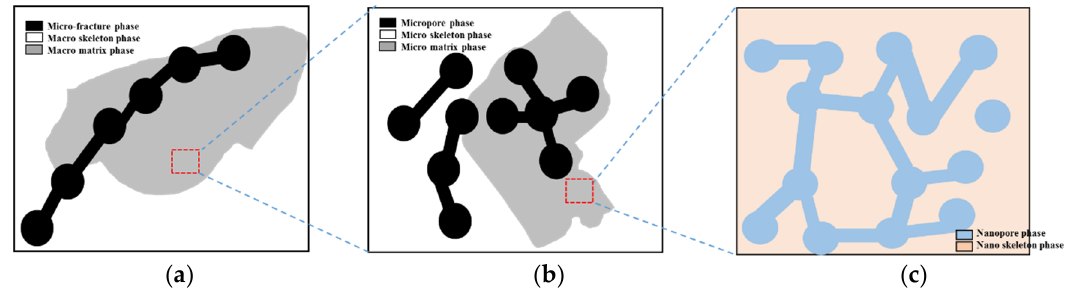
Figure 3. Multi-threshold segmentation of micro/nanoscale gray image: ( a ) Three-phase segmenta- tion; ( b ) three-phase segmentation; and ( c ) two-phase segmentation.